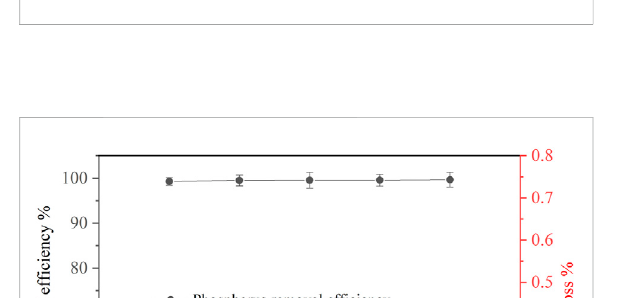
FIGURE 8 Effect of initial phosphorus concentration on phosphorus removal (basic magnesium carbonate stoichiometric ratio 1.5, temperature 25 ° C, agitation speed 250 rpm, reaction time 120 min).